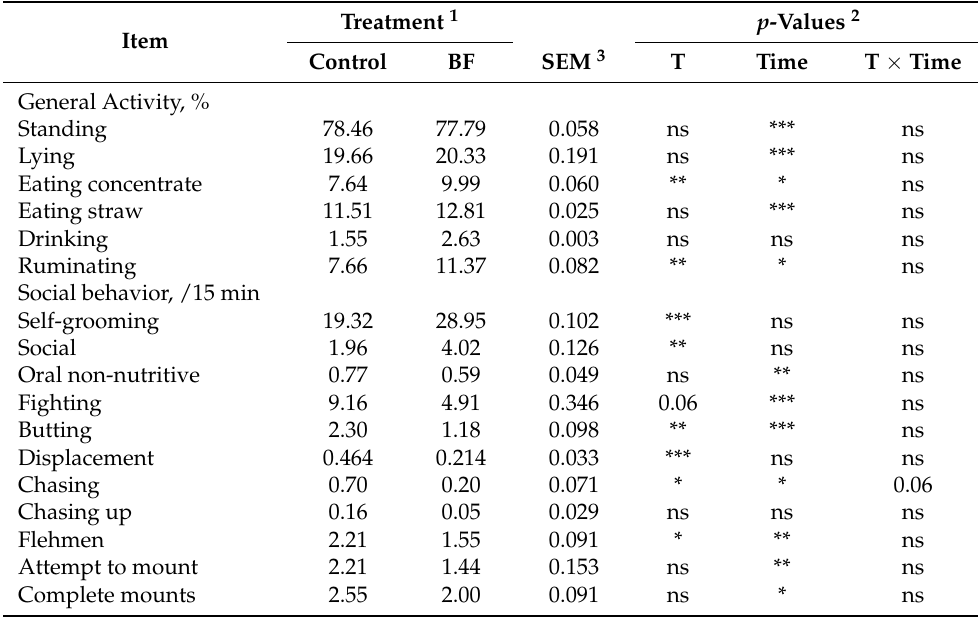
Table 3. General activities (%) and social behavior (times/15 min) for growing phase in Holstein bulls fed high-concentrate diets supplemented with citrus flavonoids. Item